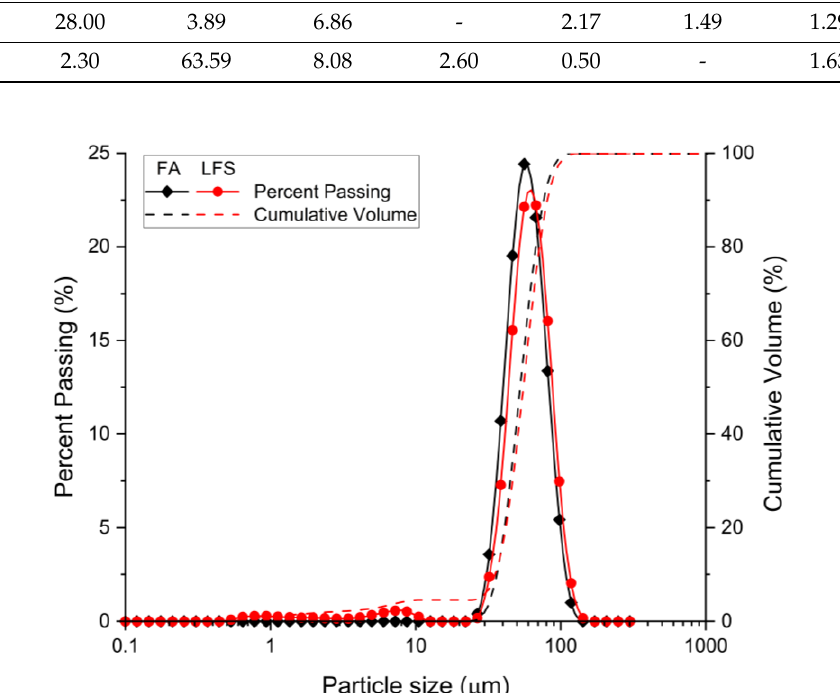
Figure 1. Particle size distribution of FA and LFS.